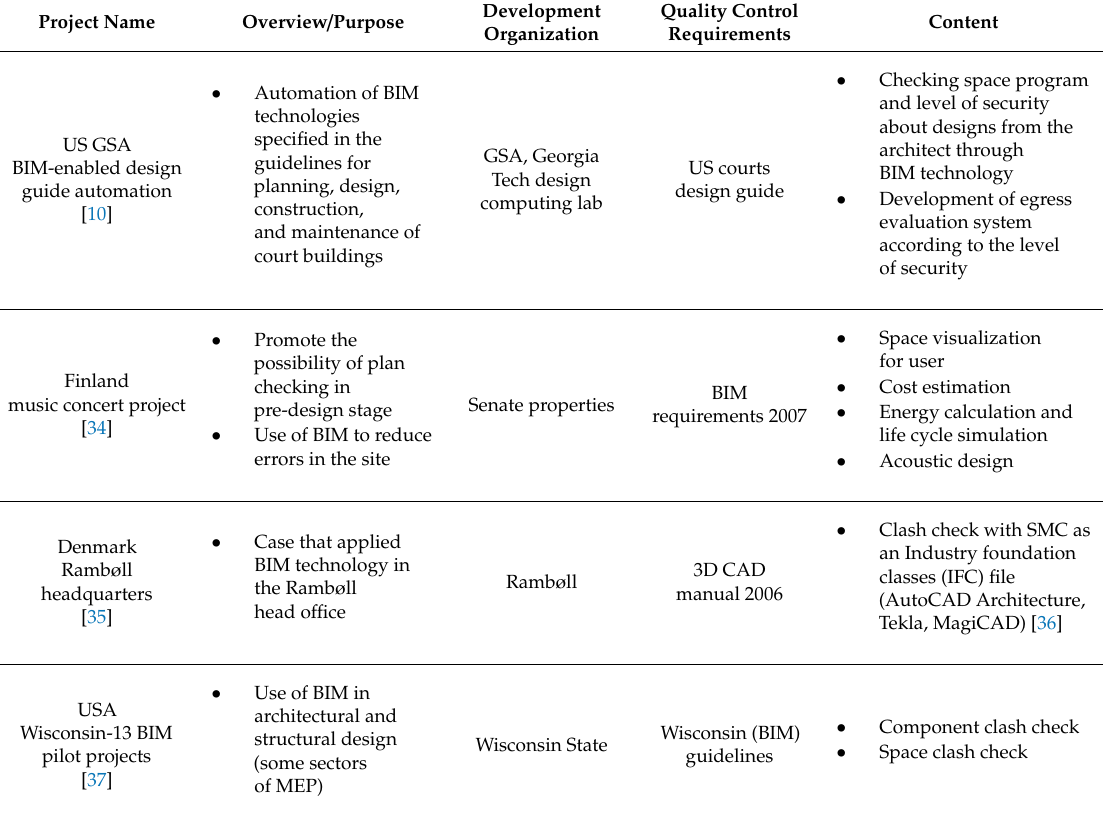
Table 3. Case studies for quality